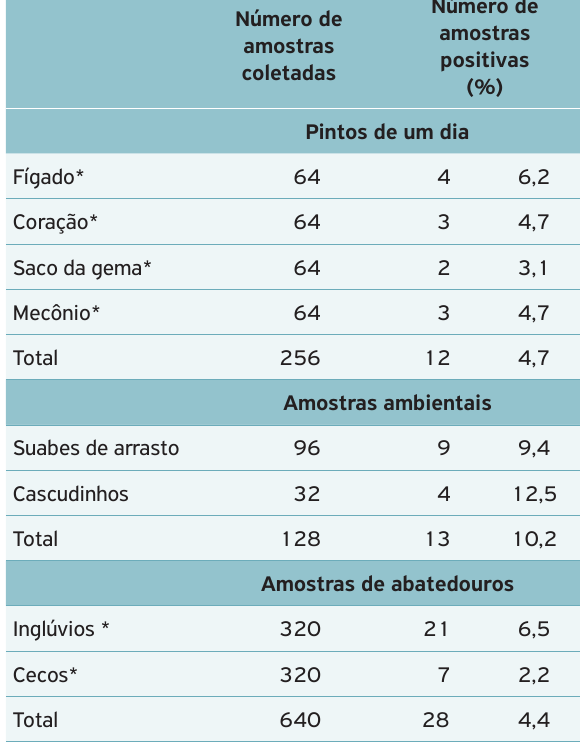
Tabela 1. Frequência de Salmonella sp. isoladas no fluxo de produção de frangos de corte e no abatedouro de 32 lotes de frango de